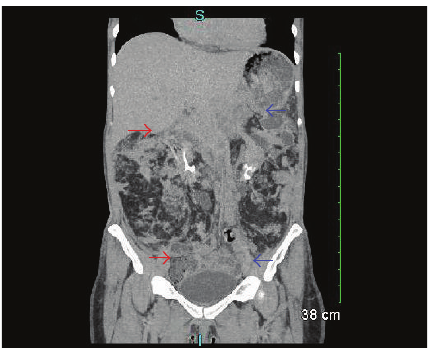
Figure 1: Coronal view of CT urogram showing extensive bilateral AML. Red arrows denote right AML. Blue arrows denote left